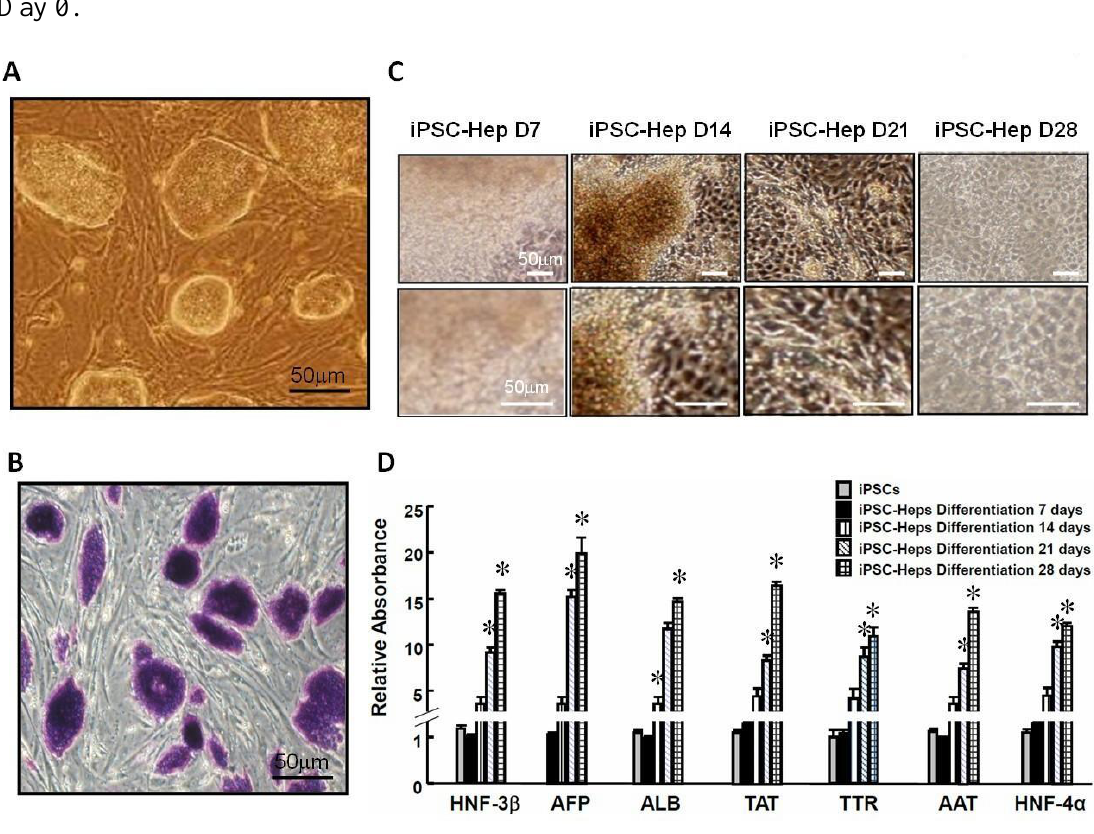
Figure 1. Differentiation of 3-genes iPSCs (induced pluripotent stem cells) into 3-genes iPSC-Heps. ( A ) 3-genes iPSCs are capable of forming colonies similar in appearance to mouse embryonic stem cells (ESCs) and 4-genes iPSCs; ( B ) Colonies of 3-genes iPSCs stained positive for alkaline phosphate; ( C ) Morphological changes of 3-genes iPSC-Heps during hepatocyte differentiation; ( D ) Recruitment of hepatocyte-specific genes, including HNF-3β,  FP, ALB, TTR, AAT, TAT, and HNF-4α during the course of hepatocyte differentiation. In panels A, B and D, scale bar = 50 μm. In panel D, data shown here are the mean ± SD of three independent experiments. * P < 0.05 vs . undifferentiated iPSCs at Day